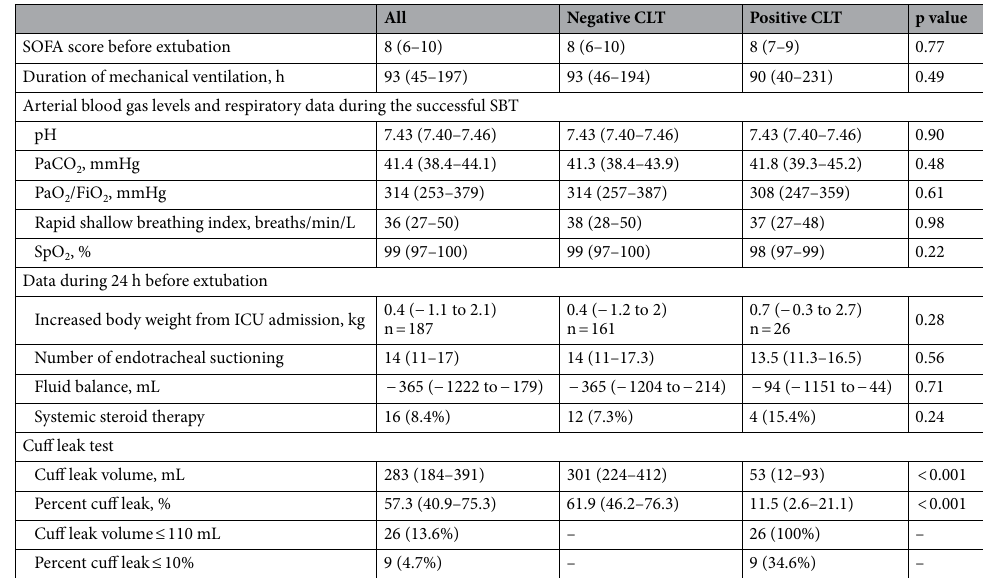
Table 2. Data at extubation and the detail of CLT. Data are presented as median and interquartile range or number (percentage). The positive CLT was defined as the cuff leak volume ≤ 110 mL and/or the percent cuff leak ≤ 10% CLT cuff leak test, SOFA sequential organ failure assessment, SBT spontaneous breathing trial.